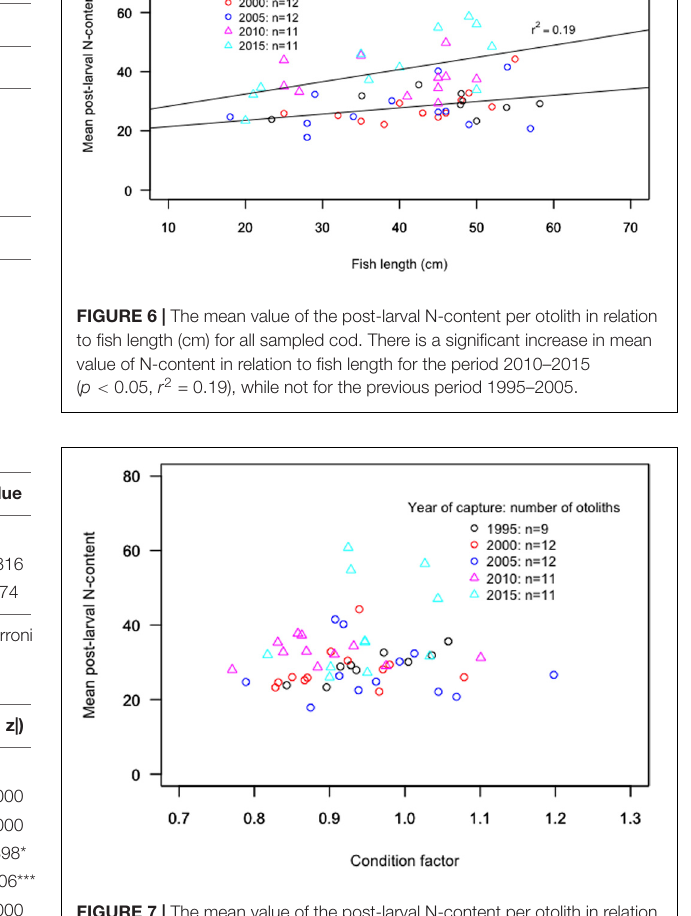
TABLE 4 | Summary of linear mixed regression model for logarithmically transformed post-larval NPS with year of sampling ( Year ) and Ontogenic stage as fixed factors.